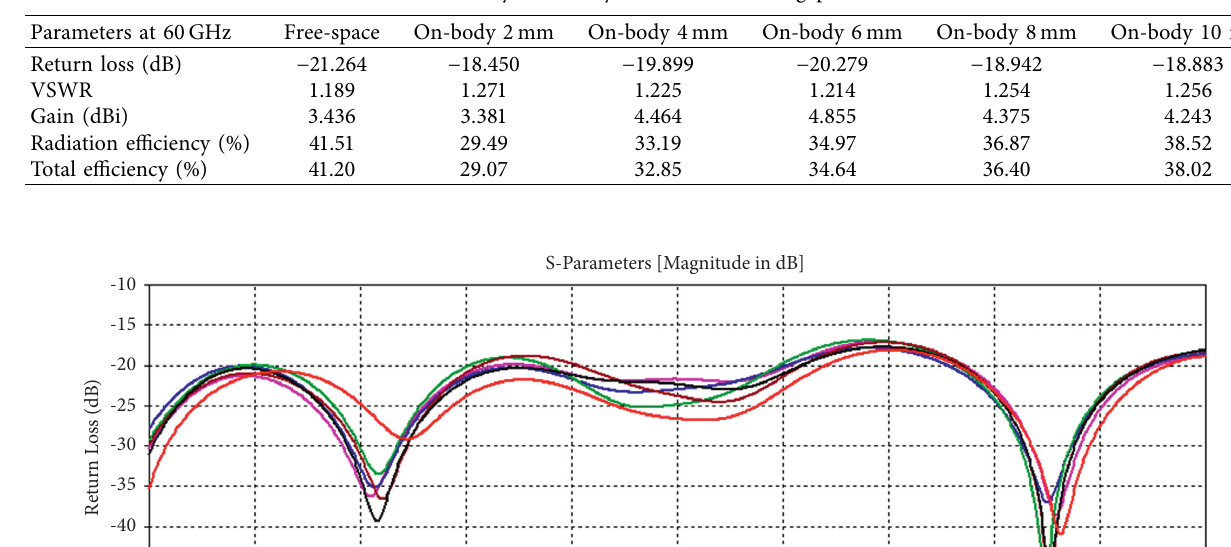
Table 8: Array 2 on-body results at different gap distances.